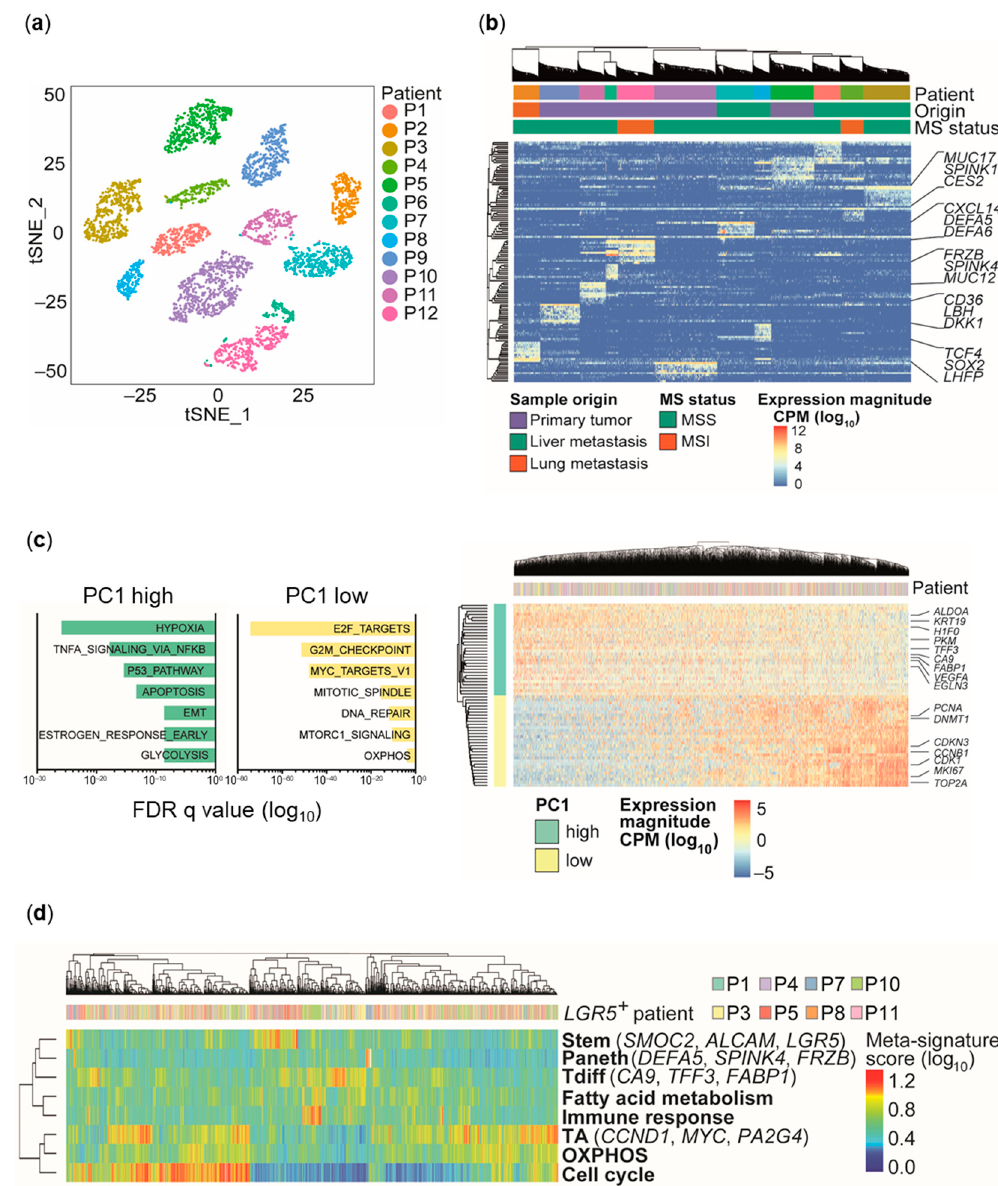
Figure 1. Identification of transcriptional subpopulations by single-cell RNA-sequencing (scRNA-seq). ( a ) Two-dimensional t-distributed stochastic neighbor embedding (tSNE) visualization of scRNA-seq expression profiles. ( b ) Hierarchical clustering and heatmap visualization of single-cell gene expression using the top 10 differentially expressed genes per patient ( n = 12). CPM, counts-per-million; MS, microsatellite; MSI, microsatellite instable; MSS, microsatellite stable. ( c ) Principal component analysis of scRNA-seq data corrected for inter-patient variability. Left: Gene set enrichment analysis (GSEA) for the first principal component (PC1; hallmark gene sets). Gene sets are ranked by false discovery rate (FDR) q values. Right: Heatmap showing gene expression magnitude of the top 30 genes with highest and lowest PC scores for PC1. OXPHOS, oxidative phosphorylation. ( d ) Heatmap reflecting hierarchical clustering of core meta-signature scores of eight LGR5 + CRC spheroid cultures determined by non-negative matrix factorization. Brackets indicate marker genes for specific signatures. TA, transit-amplifying; Tdiff, terminally